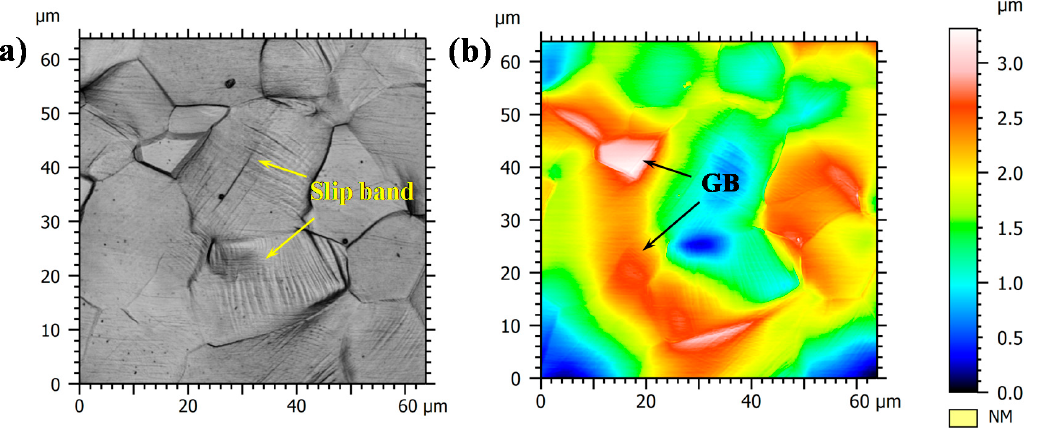
Figure 7. The surface topography of CP-Ti after in situ tensile stain of ~22.5%: ( a ) the optical microstructure, and ( b ) the corresponding two-dimensional surface topography.